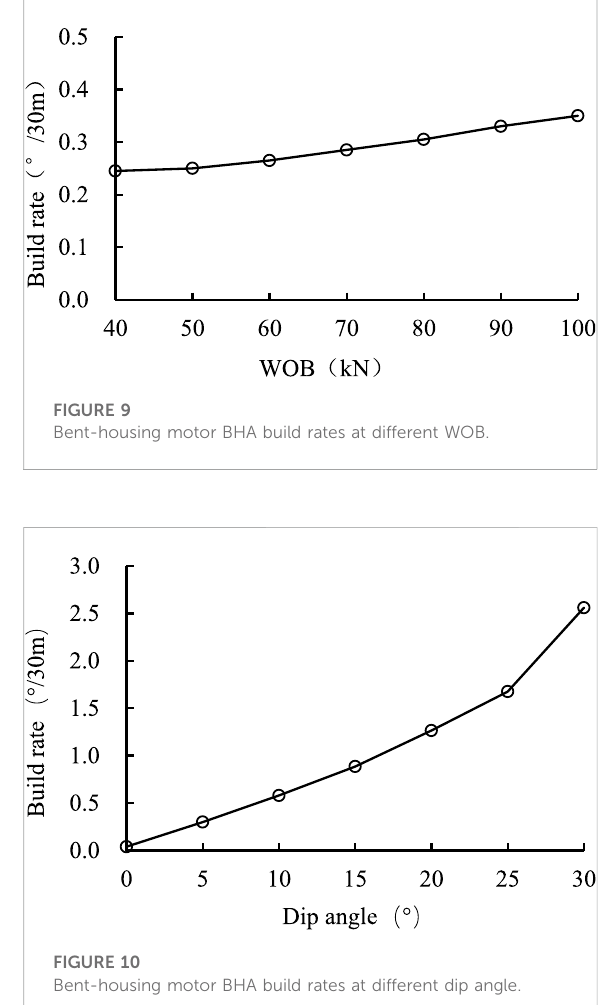
FIGURE 10 Bent-housing motor BHA build rates at different dip